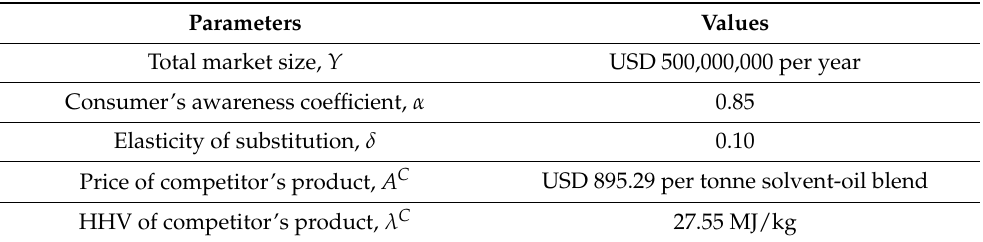
Table 2. Parameters and values from market analysis. Parameters Values Total market size, Y USD 500,000,000 per year Consumer’s awareness coefficient, α 0.85 Elasticity of substitution, δ